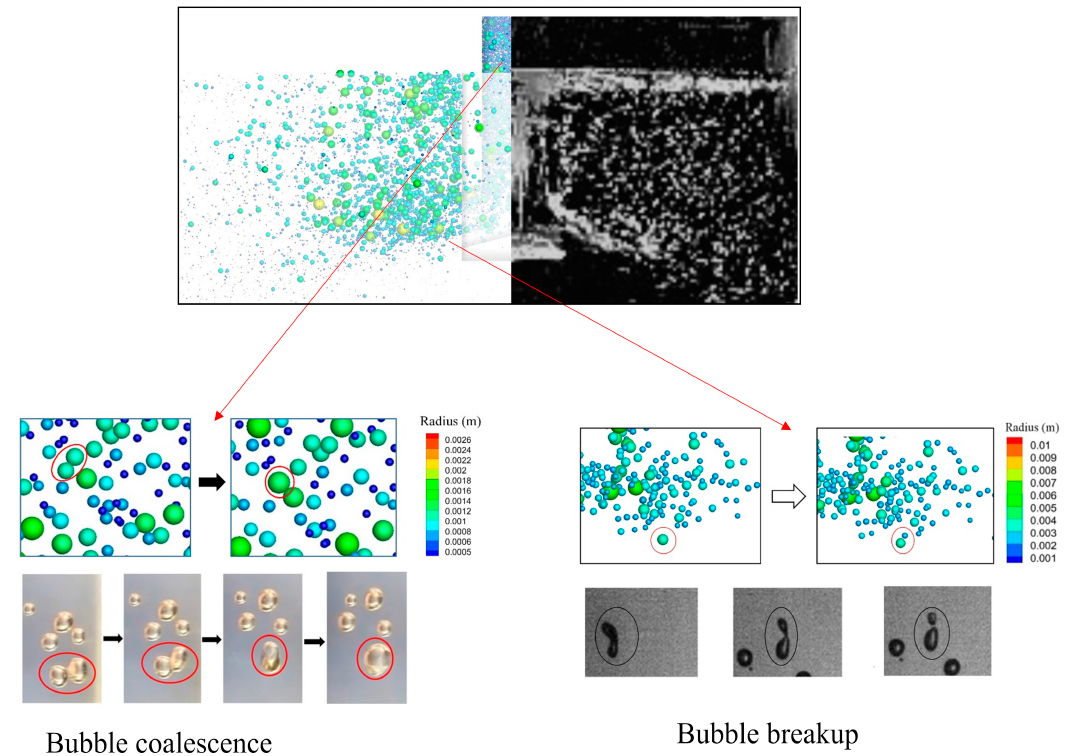
Figure 3. Comparison of bubble behavior between the simulation and water model.